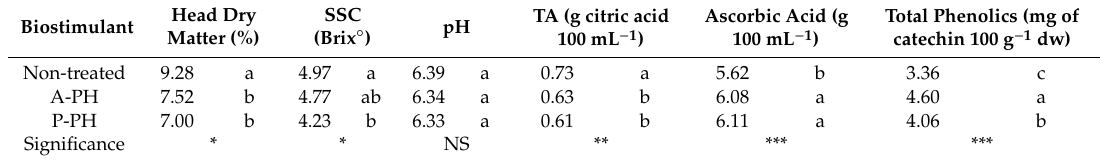
Table 3. E ff ect of di ff erent PHs on head dry weight, soluble solid content (SSC), pH, titratable acidity (TA), ascorbic acid and total phenolics of